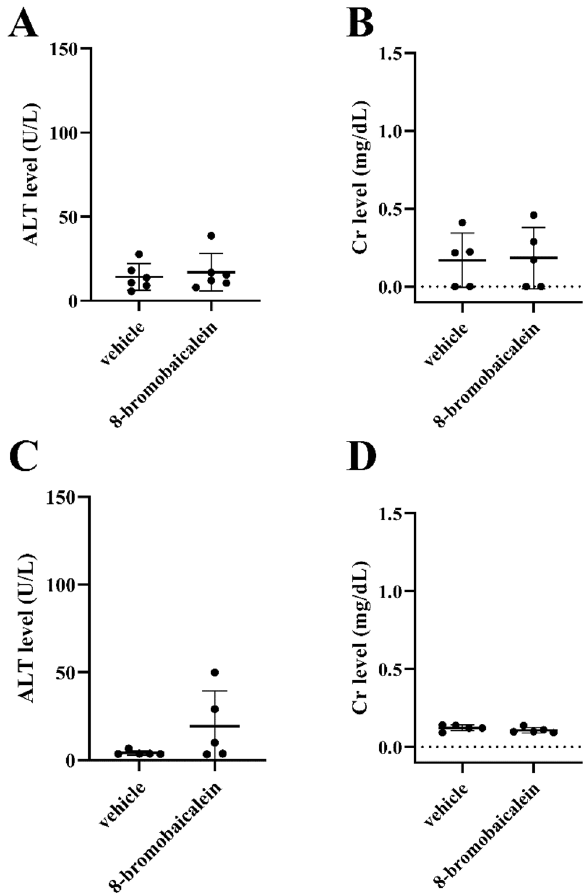
Figure 6. Animal Toxicity. ( A ) ALT and ( B ) Cr levels in infant mice and ( C ) ALT and ( D ) Cr levels in adult mice taken at the 8 th day after seven consecutive days of 10 mg/kg 8-bromobaicalein, once daily, intraperitoneal administration. Plasma samples were collected for analysis of hepatorenal functions. Each data point represented the ALT or Cr levels of each individual. Error bars indicated the standard deviation of the means. No significant differences between the two populations were found (unpaired